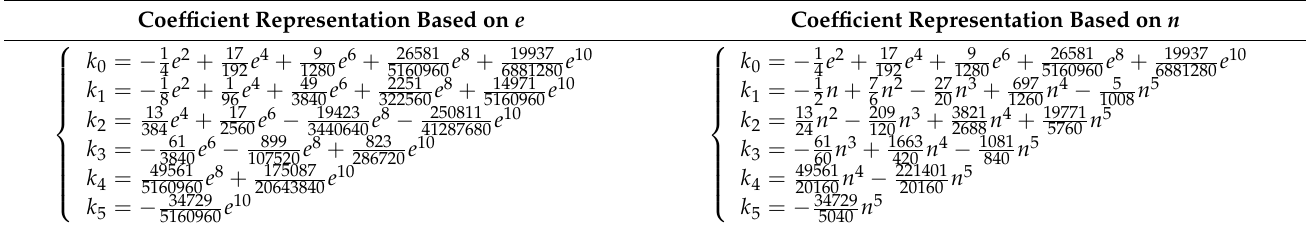
Table 6. Coefficients in Equation